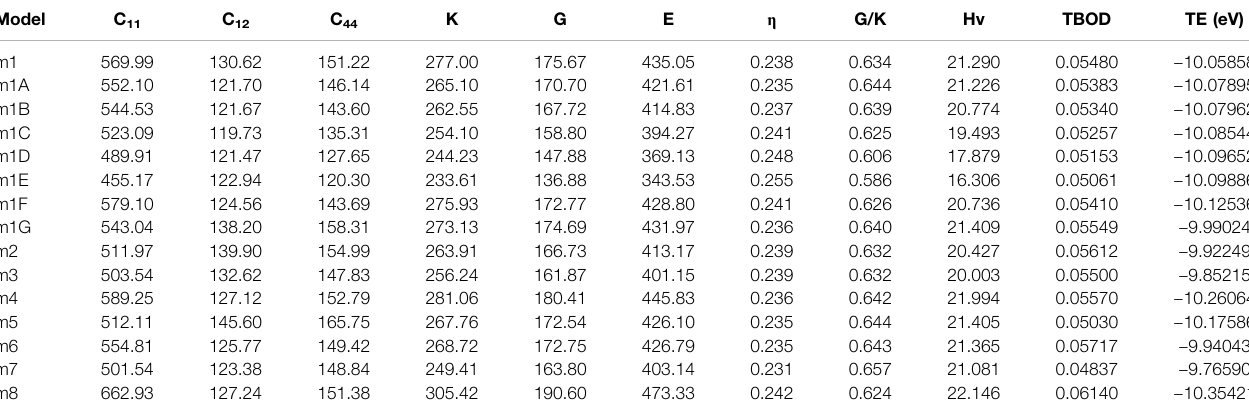
TABLE 2 | Elastic coef fi cient C ij , bulk modulus (K), shear modulus (G) and Young ’ s modulus (E) in unit of GPa in 15 FCC HEAs. Model